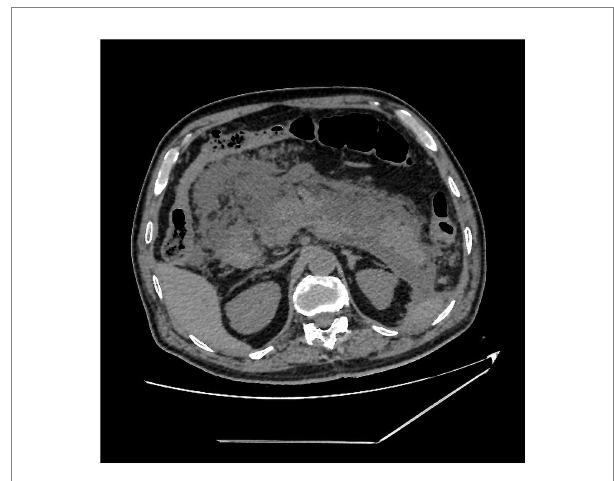
FIGURE 3 Abdominal CT showed diffuse enlargement of the pancreas and extensive peripancreatic exudation 14 h post endoscopy treatment.